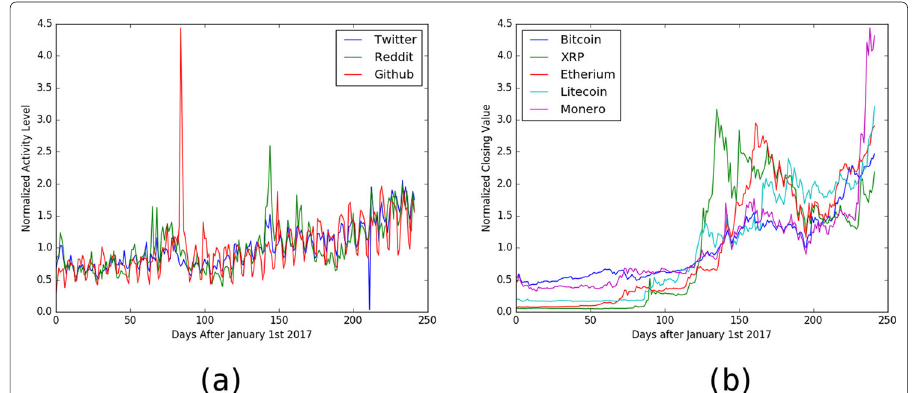
Fig. 1 Time series details for ( a ) activity levels on social media and ( b ) market price at 14:00 GMT. Here all time series have been normalized such that their mean is